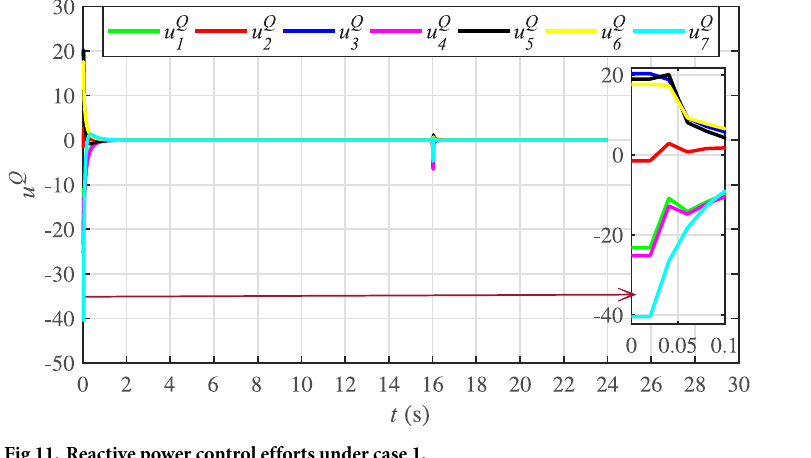
Fig 11. Reactive power control efforts under case